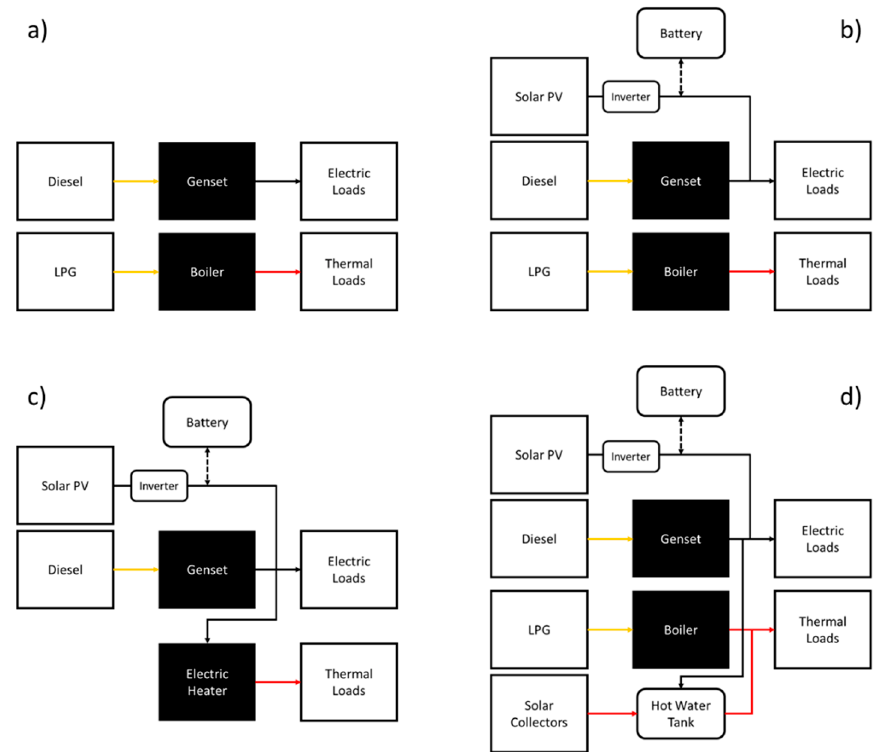
Figure 2. Schematic summary of the four scenarios considered: ( a ) traditional energy system; ( b ) conventional micro-grid; ( c ) multi-good micro-grid; ( d ) integrated multi-energy system.